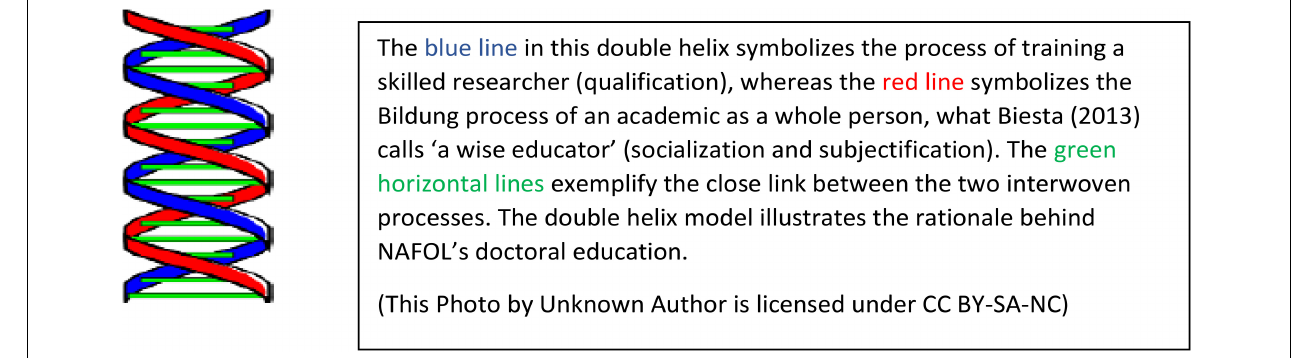
FIGURE 1 | NAFOL’s rationale. The blue line in this double helix symbolizes the process of training a skilled researcher (qualification), whereas the red line symbolizes the Bildung process of an academic as a whole person, what Biesta (2013) calls ‘a wise educator’ (socialization and subjectification). The green horizontal lines exemplify the close link between the two interwoven processes. The double helix model illustrates the rationale behind NAFOL’s doctoral education. (This Photo by Unknown Author is licensed under CC BY-SA-NC).